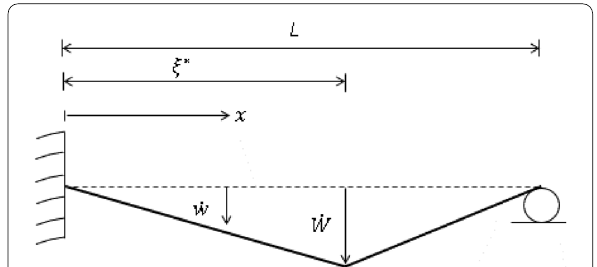
Fig. 8 Distribution of transverse velocity during Phase 1 of the